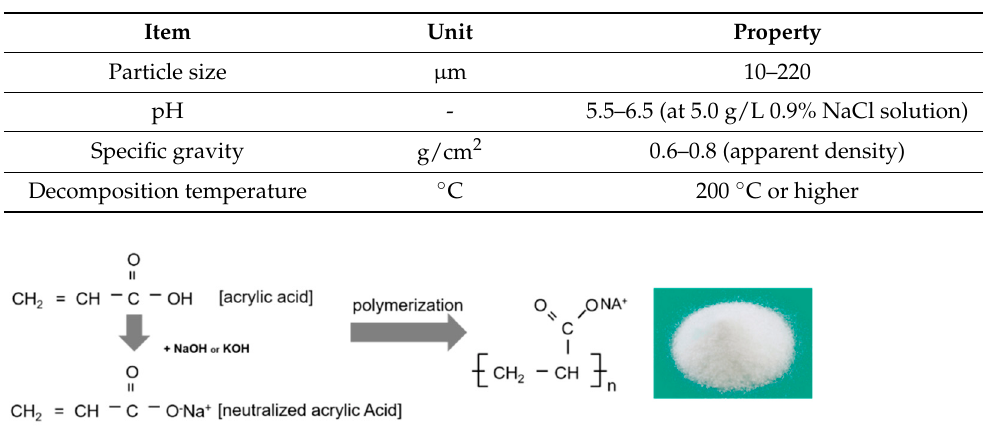
Table 1. The properties of superabsorbent polymers.